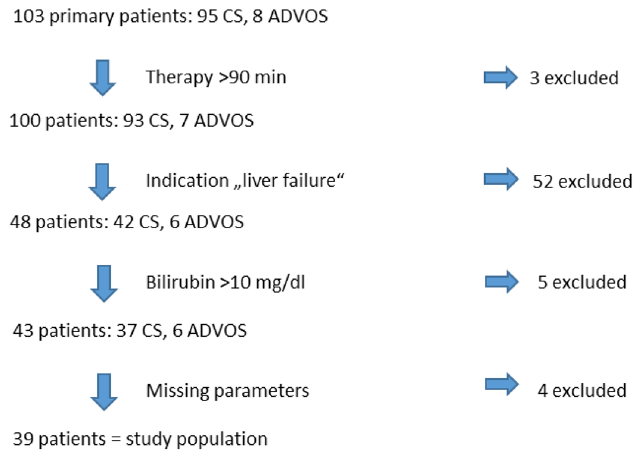
Figure 1. Selection of the study population. CS: CytoSorb, ADVOS: advanced organ